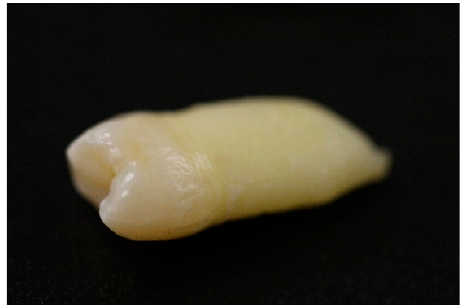
Figure 1. Extracted premolar.